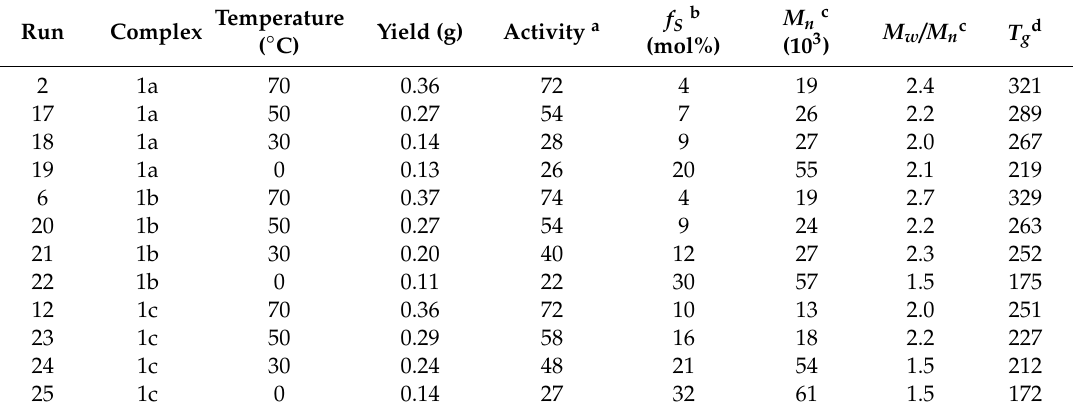
Table 2. E ff ects of temperature of N / S copolymerization by 1 -MMAO. Temperature Yield (g) Activity a Run Complex ( ◦ C)